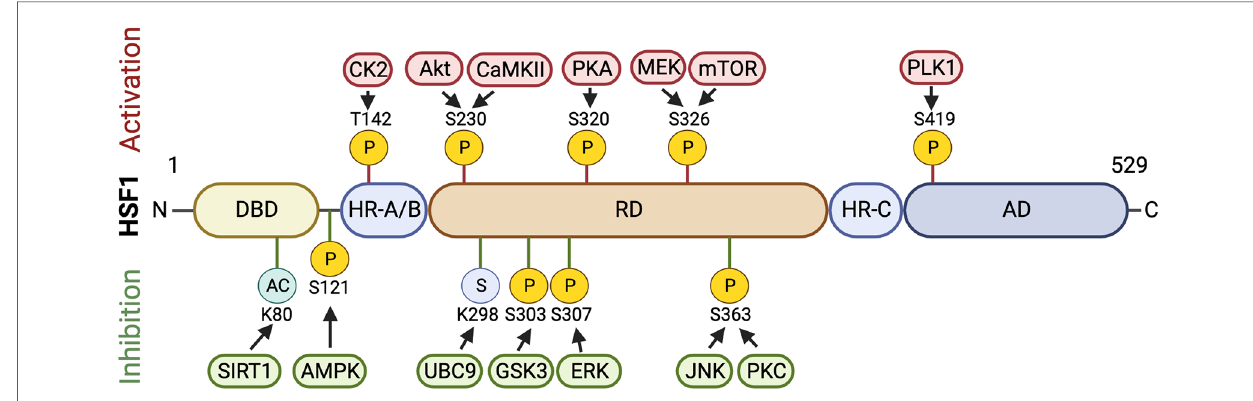
FIGURE 2 HSF1 regulatory domains and post-translational modi fi cations. HSF1 is composed of several functional domains, including a DNA-binding domain (DBD), a regulatory domain (RD), a heptad repeat (HR), and a transactivating domain (AD). Speci fi c sites for serine/threonine phosphorylation (P), acetylation (AC), and SUMOylation (S) that activate or inhibit HSF1 ’ s activity are shown. These post-translational modi fi cations are mediated by a variety of kinases, de- acetylases, and SUMOylases. AMPK, AMP-activated protein kinase, Akt, protein kinase B; CaMKII, calcium/calmodulin-dependent protein kinase II; CK2, casein kinase 2; ERK, extracellular signal-regulated kinase; GSK3, glycogen synthase kinase 3; JNK, c-Jun N-terminal kinase; mTOR, mammalian target of rapamycin; MEK, mitogen-activated protein kinase; PKA, protein kinase A; PKC, protein kinase C; PLK1, polo-like kinase 1; SIRT1, sirtuin 1; UBC9, ubiquitin-conjugating enzyme E2I. Images were created with